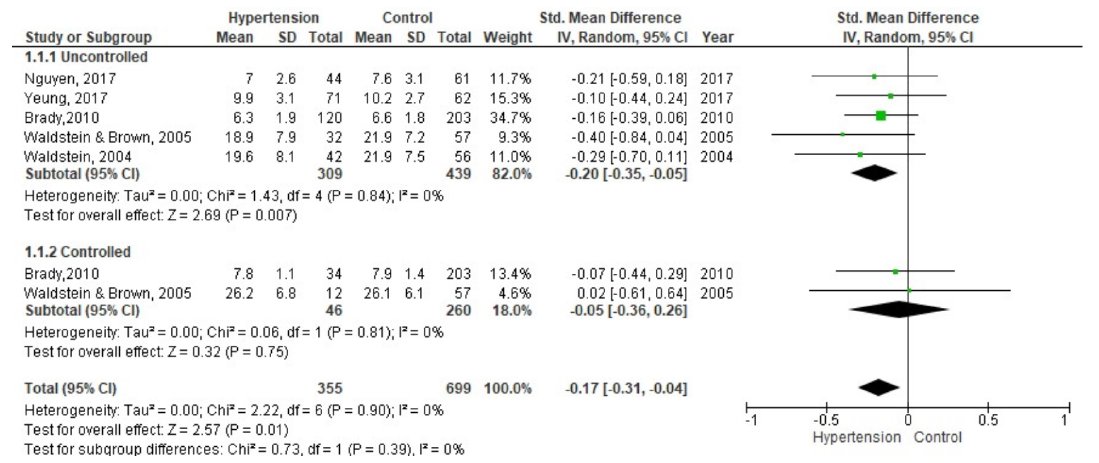
Figure 5. Meta-analysis on the comparison of groups with controlled and uncontrolled hypertension between the control group in delayed